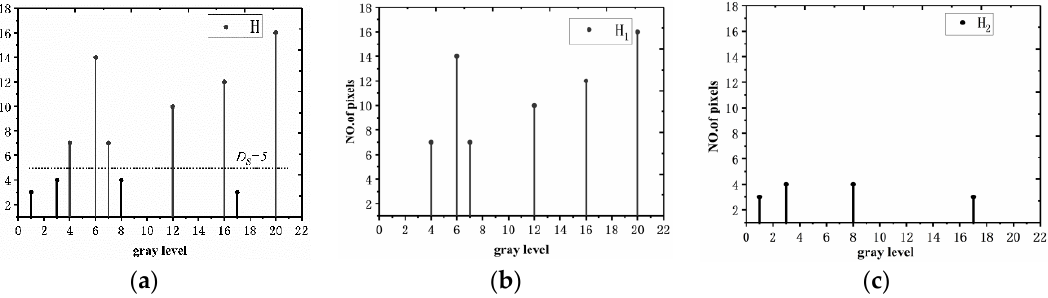
Figure 2. Histogram segmentation diagram: ( a ) input image histogram, ( b ) sub-histogram H 1 , ( c ) sub-histogram H 2 .